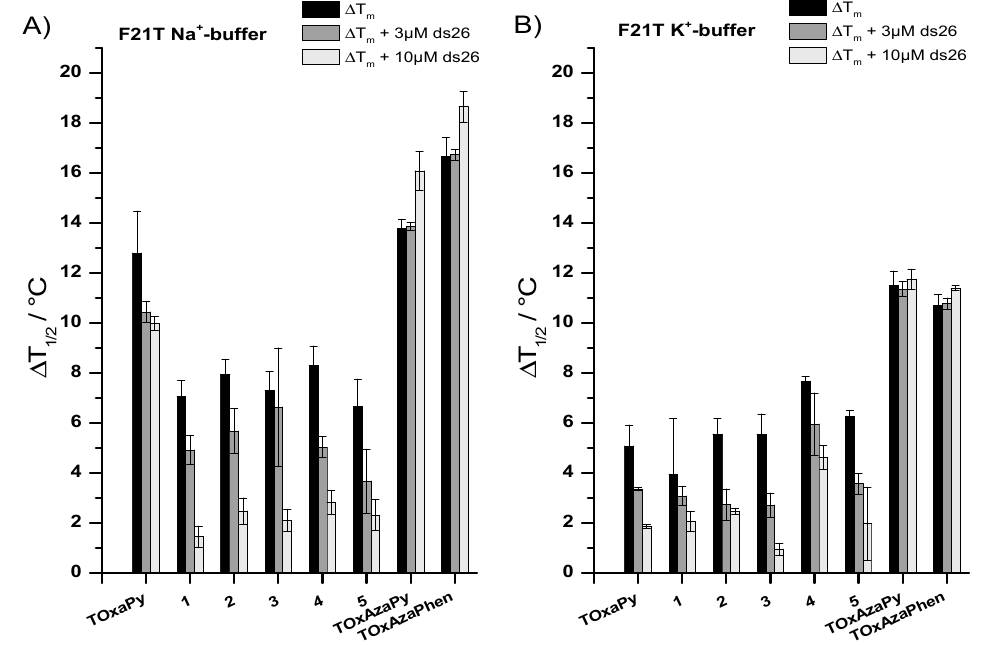
Figure 3. Quantitative analysis of the FRET-melting competition experiments with the telomeric sequence F21T (0.2 µ M). Stabilization in: ( A ) Na-rich buffer; or ( B ) K-rich buffer is indicated for the reference compound TOxaPy, in the absence (black bars) or in the presence of double-stranded DNA (ds26) at 3 µ M (dark grey bars) or 10 µ M (fair grey bars). Analysed compounds: 1 – 5 , TOxAzaPy ( 6 ) and TOxaAzaPhen ( 7 ) (1 µ M). Error bars corresponds to SD of three independent experiments. Experiments were performed in: ( A ) 10 mM lithium cacodylate buffer (pH 7.2), 100 mM NaCl; and ( B ) 10 mM lithium cacodylate buffer (pH 7.2), 90 mM LiCl, and 10 mM